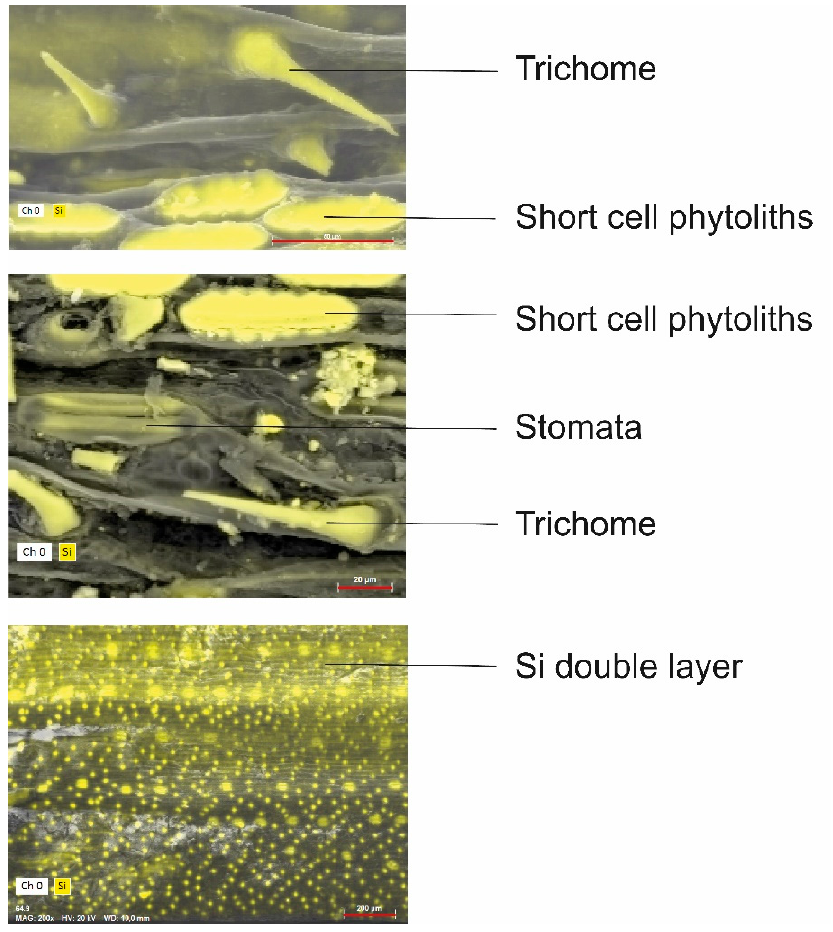
Figure 2. Different Si deposits occurring in the leaves of grasses. Here SEM-EDX pictures of wheat left at maturity. The red line indicates the scale for the different pictures (50 µm top, 20 µm middle and 200 µm bottom picture). The SEM-EDX analysis results were provided by J. Busse (ZALF, Germany).